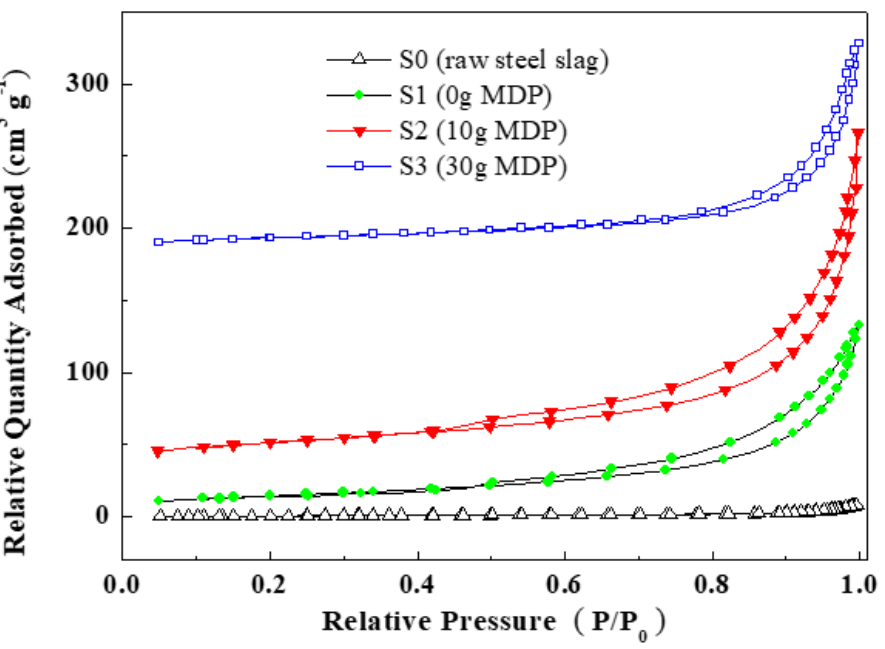
Figure 3. Nitrogen adsorption/desorption isotherm curves of raw steel slag and the nanocompo- site samples prepared with different additions of MDP. The relative quantity adsorbed value was calculated for the standard temperature and pressure conditions.